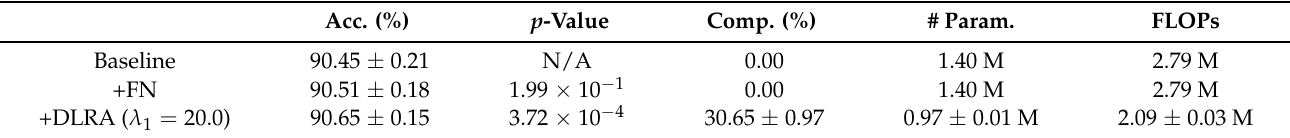
Table 1. Ablation results, on the Fashion-MNIST test set after training for 2000 epochs. Acc = accuracy, Comp = compression rate, # Param = number of trainable parameters, FLOPs = number of floating point operations for a single inference step, FN = Frobenius normalization, DLRA = dynamic low-rank approximation. P -values are calculated against the baseline